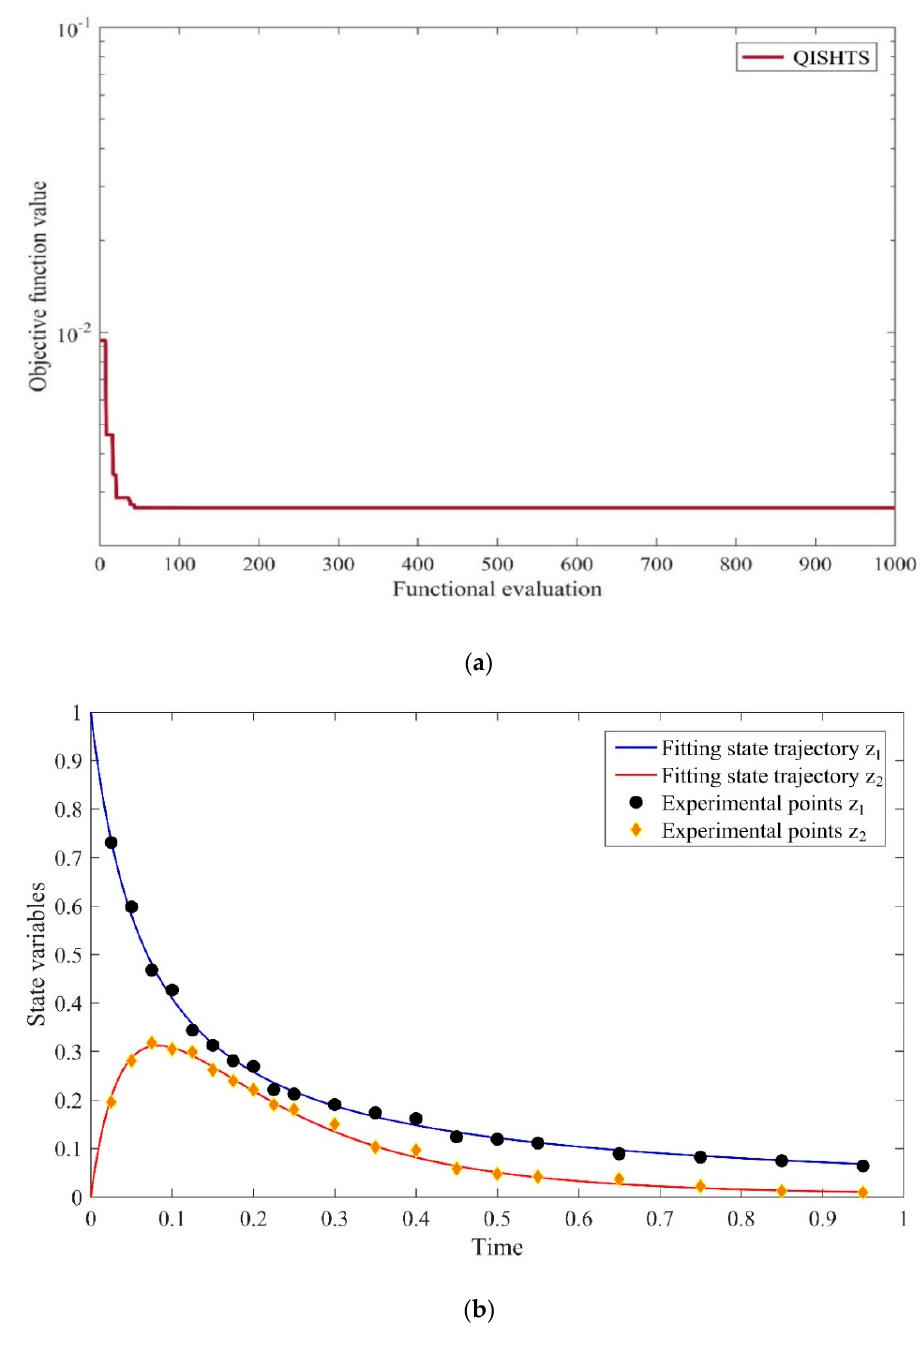
Figure 4. ( a ) Convergence graph of QISHTS algorithm for the catalytic cracking of gas oil model. ( b ) Fitting state trajectories and experimental points for the catalytic cracking of gas oil model.